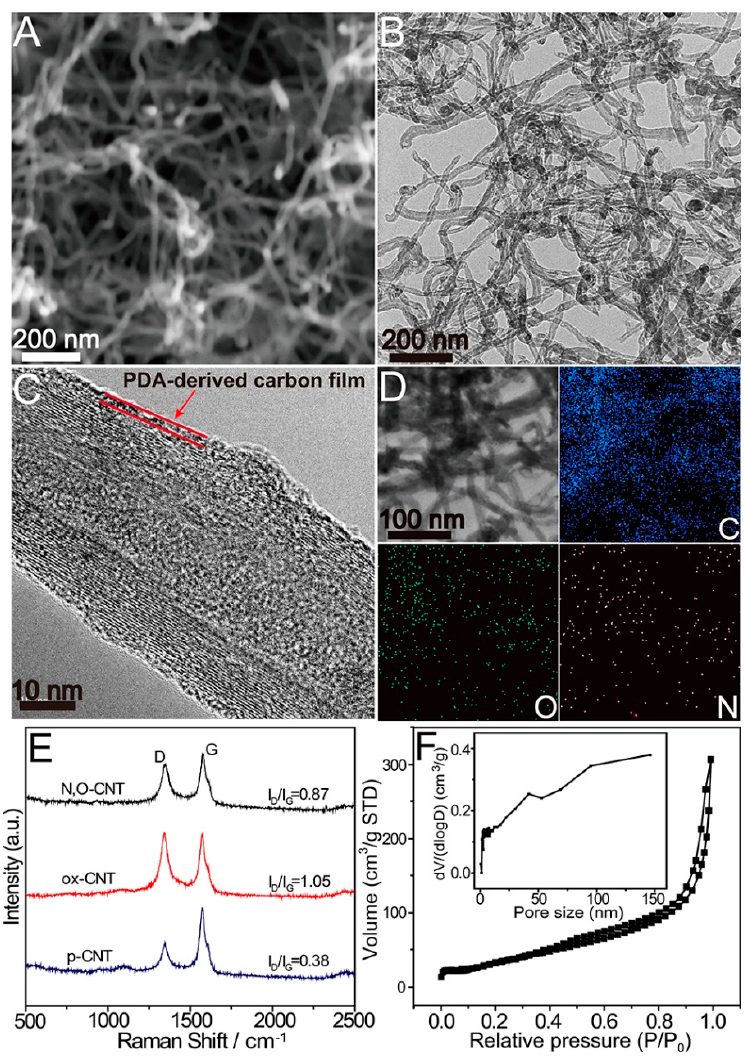
Figure 1. ( A ) SEM, ( B ) TEM and ( C ) the magnified TEM images of the N, O-carbon nanotube (CNT); PDA, polydopamine. ( D ) TEM elemental mapping of C, O, and N in N, O-CNT. ( E ) Raman spectra of p-CNT, ox-CNT and N, O-CNT. ( F ) The corresponding nitrogen adsorption–desorption isotherm of N, O-CNT, and the inset shows the pore size distribution curve.